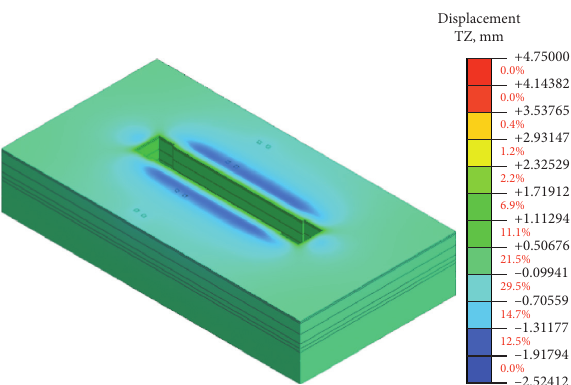
Figure 13: Cloud map of ground settlement after grouting